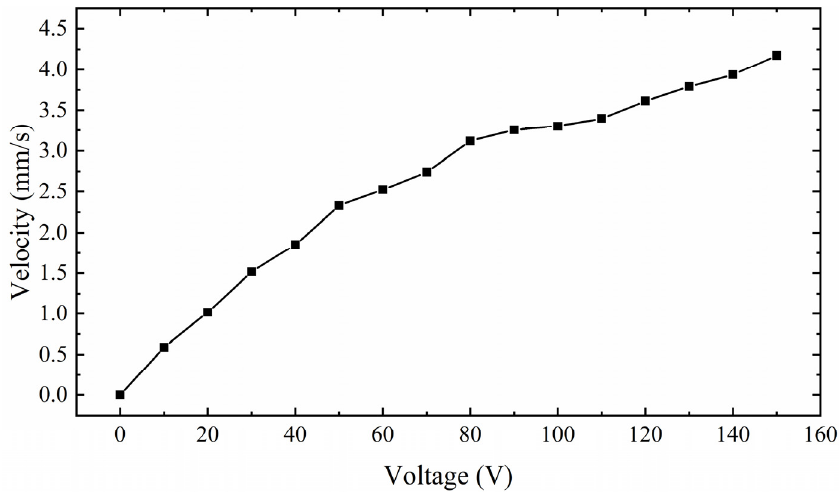
Figure 27. Relationship between mover speed and voltage excitation V p-p .